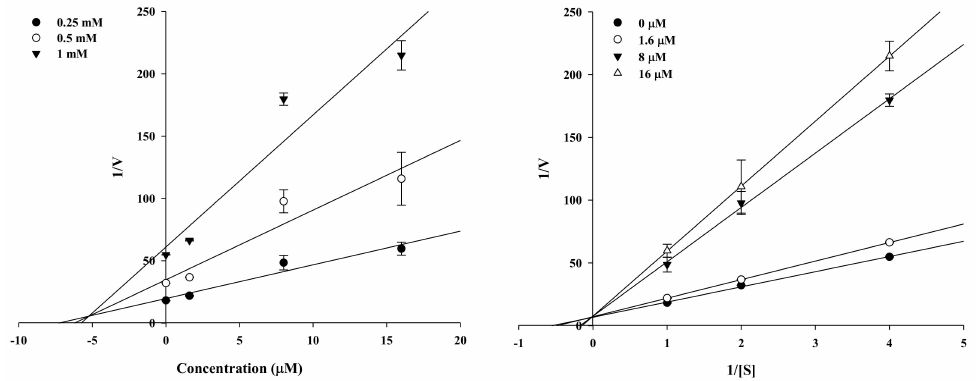
Figure 3. Dixon plots and Lineweaver–Burk plots for mushroom tyrosinase inhibition of mulberrofuran G.